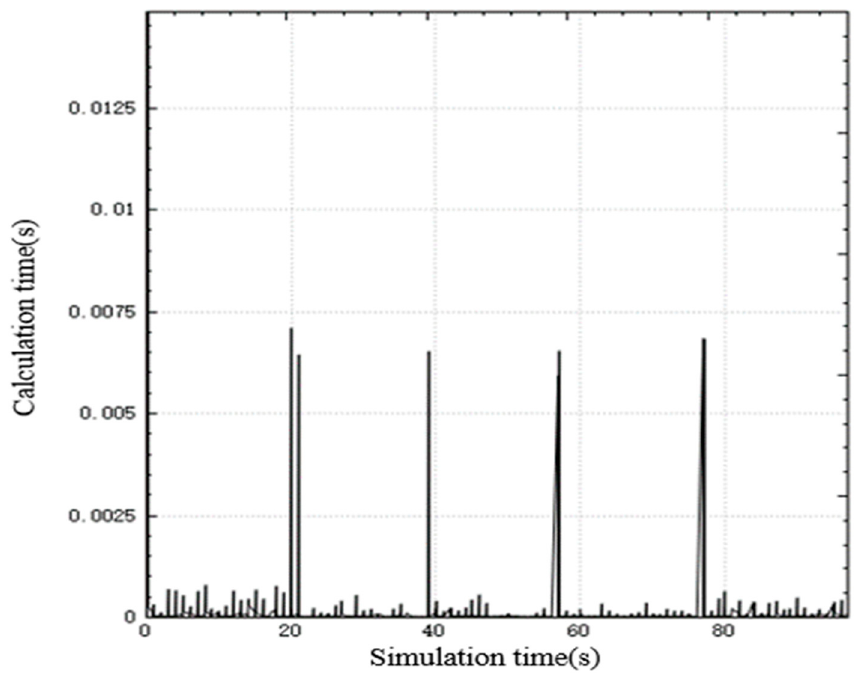
Figure 9. Calculate time-consuming curve in each step.